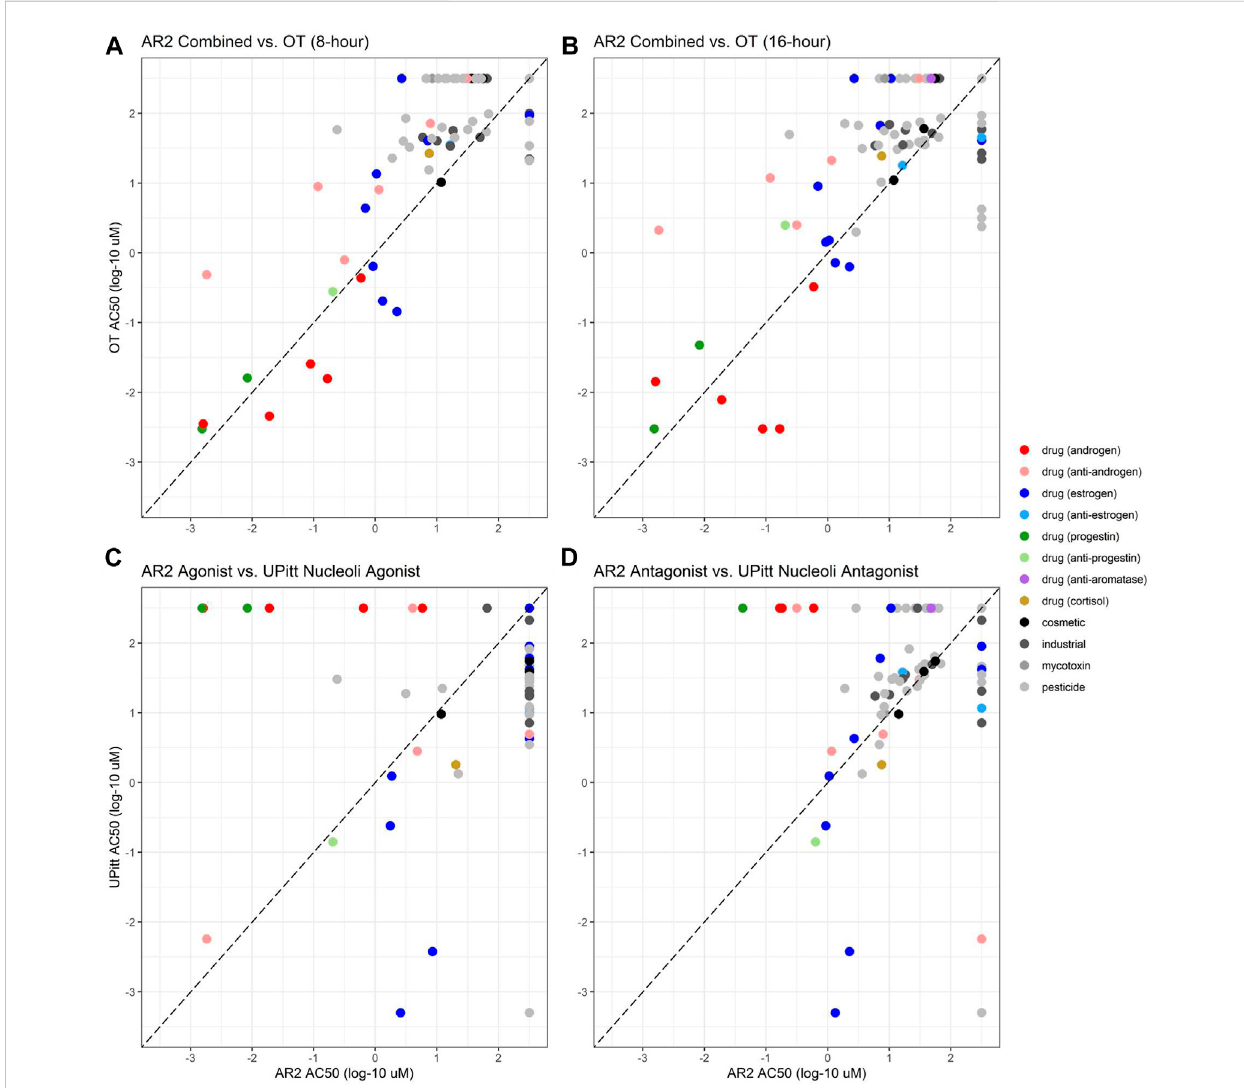
FIGURE 4 Comparison of AR2 bioactivity with legacy ToxCast assay data. Activity calls and estimated potencies (AC 50 ) for chemicals tested in AR2 agonist and antagonist assay modes were compared to ToxCast data from the Odyssey Thera (OT, (A, B) and University of Pittsburgh (C, D) AR dimerization assays. AnyactivecallandthelowerAC 50 value(ifactiveinbothmodes)wasusedforAR2tofacilitateacomparisontothesinglemodeOTassayrunatboth8 (A) and16 h (B) .AR2-UPittcomparisonsmatchagonistmode (C) orantagonistmodedata.AC 50 valuesaremicromolarconcentrationsexpressedaslog 10forAR2( x -axis)andOT/UPittassays( y -axis).Thediagonaldashedlinerepresentsequipotencyinbothassays.Chemicalsabovethediagonalweremore potent in the AR2 assay and those below more potent in the OT/UPitt assays. Chemicals inactive in either assay were assigned an AC 50 of 2.5 and are aligned along the top (inactive in OT/UPitt assays) and right (inactive in AR2) of each